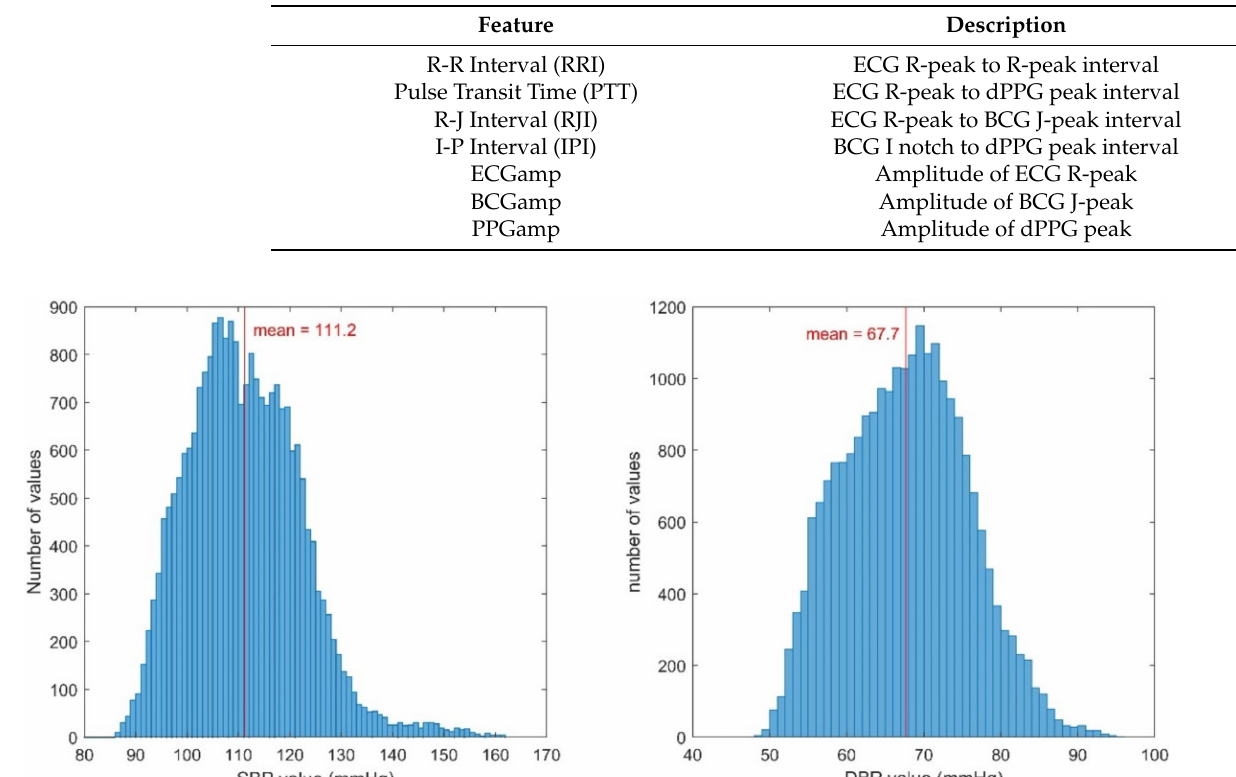
Figure 3. Blood pressure (BP) distributions of BPs in our data. ( left ) Systolic BP, ( right ) Diastolic